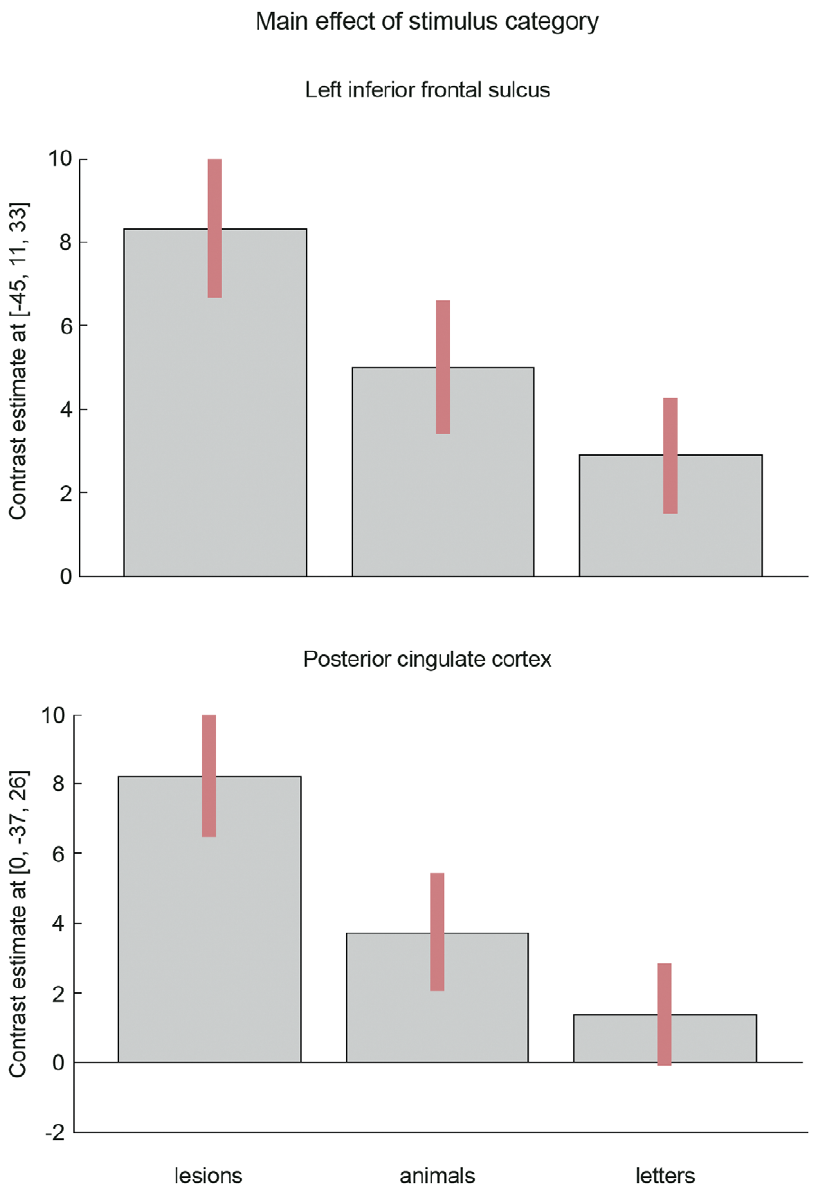
Figure 3. Contrast estimates* in cortical areas more active for diagnosing lesions # . * 90% confidence interval. # contrast [lesions . (animals and letters)] inclusively masked with lesions . baseline, lesions . animals, and lesions . letters at